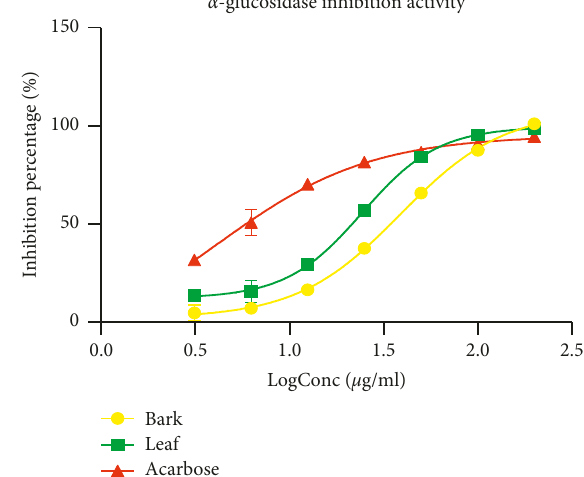
Figure 9: α -Glucosidase inhibitory activity of the hydro-ethanolic leaf and bark extracts of Psychotria densinervia and acarbose. Values are expressed as mean ± SD ( n �